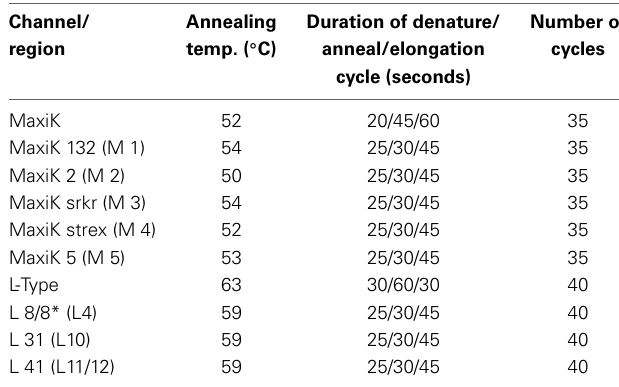
experiments in this